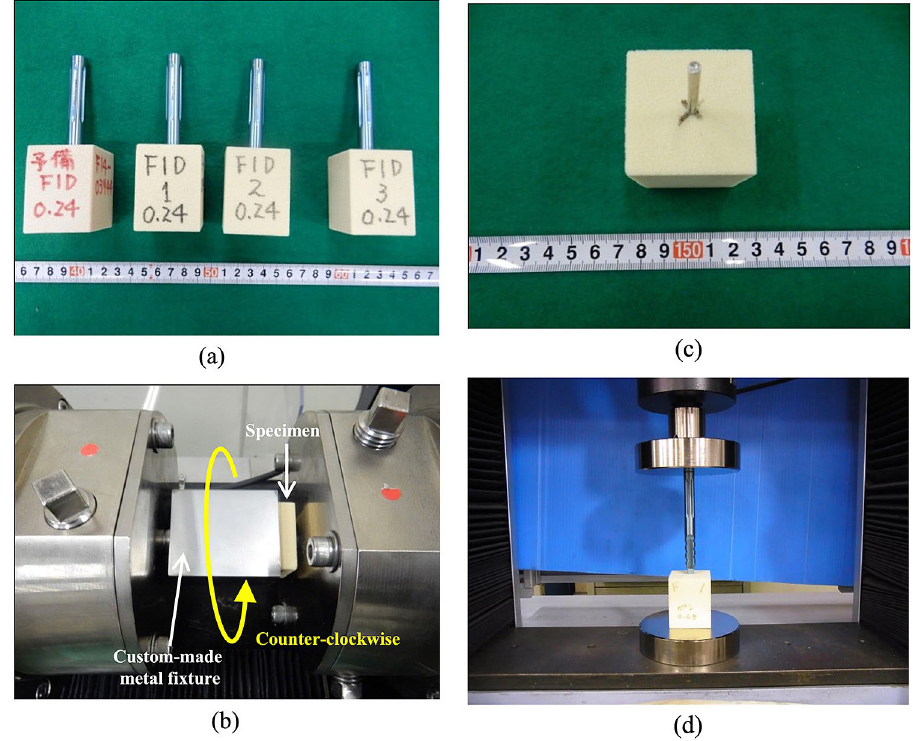
Figure 2. ( a ) Specimens of the three densities of the polyurethane block: 0.24, 0.16, and 0.08 g/cm 3 . ( b ) Shimadzu Torsional Testing machine. ( c ) Specimens inserted to a depth of 40 mm in advance. ( d ) Autograph Tensile Testing